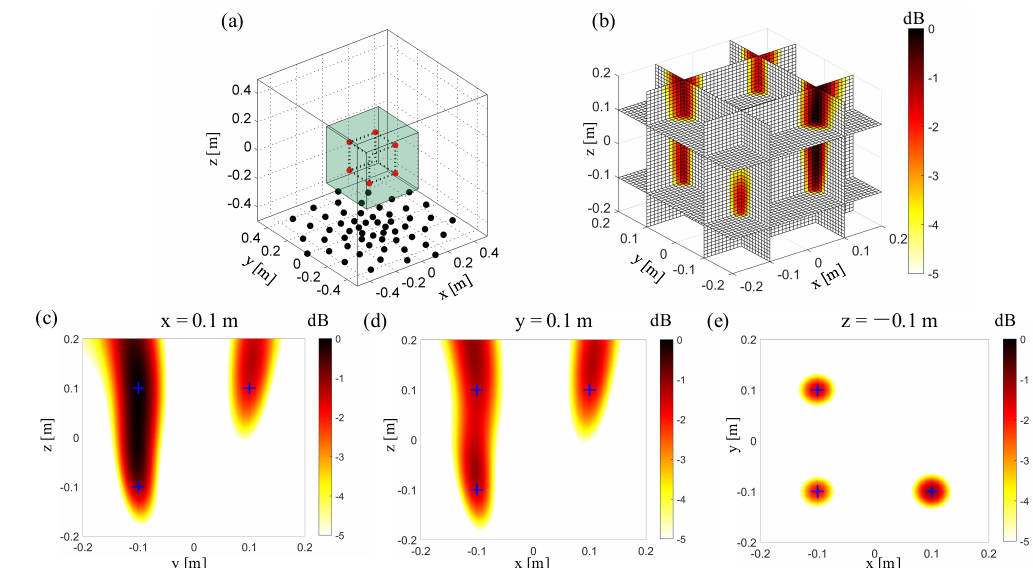
Figure 6. 3D Beamforming result with a single planar array. ( a ) The simulation setup. The red points “ · ” represent the sound sources. The other same color represents the microphones in the same test. The black points “ · ” represent the microphones in a single planar array test. ( b ) 3D beamforming map. ( c ) The beamforming map at the x = 0.1 m slice. ( d ) The beamforming map at the y = 0.1 m slice. ( e ) The beamforming map at the z = − 0.1 m slice.